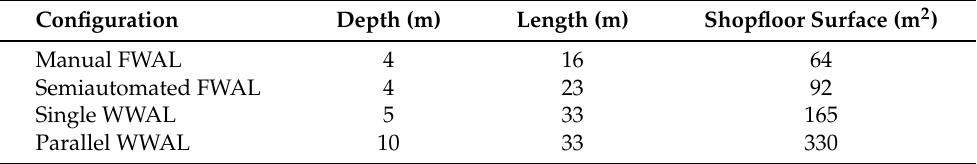
Table 7. Shopfloor surface requirements for different assembly line